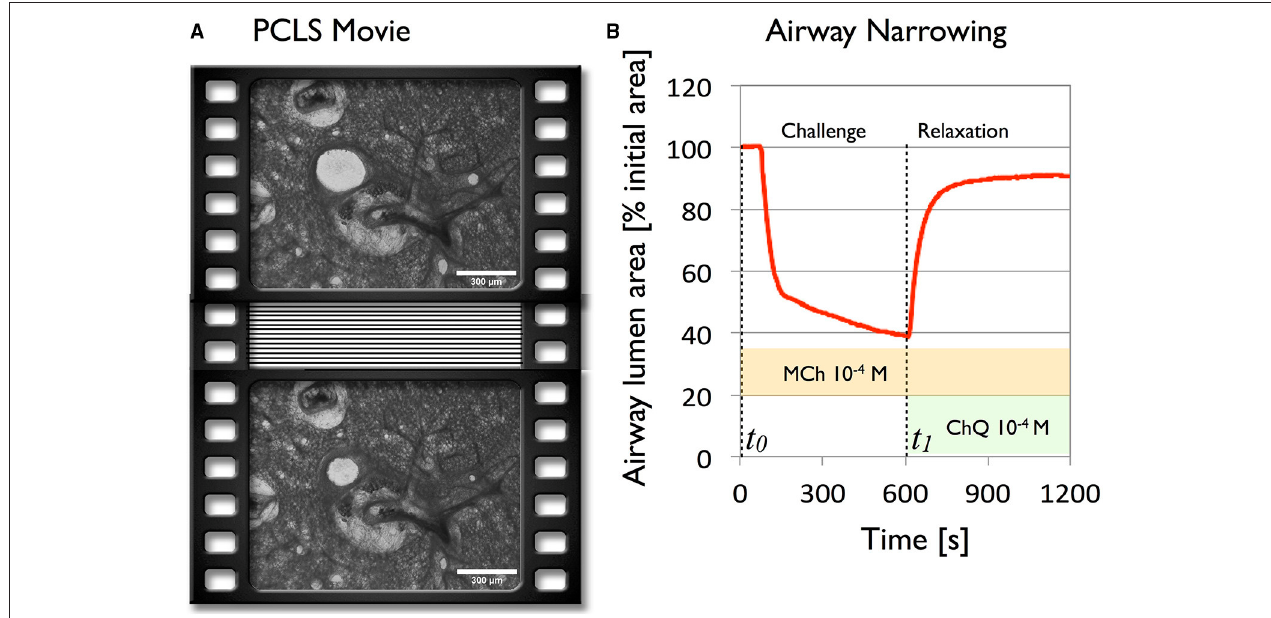
FIGURE 1 | Global analysis of the deformations of a 250 µ m mouse lung slice during agonist driven contraction with methacholine (10 − 4 M) and subsequent bitter taste receptor agonist relaxation with chloroquine (10 − 3 M), reveals the global behavior of the parenchyma. (A) Two frames of a phase contrast PCLS movie selected before ( t 0 = 0 s) and after contraction ( t 1 = 600 s). (B) Airway caliber plotted as a function of time during contraction and